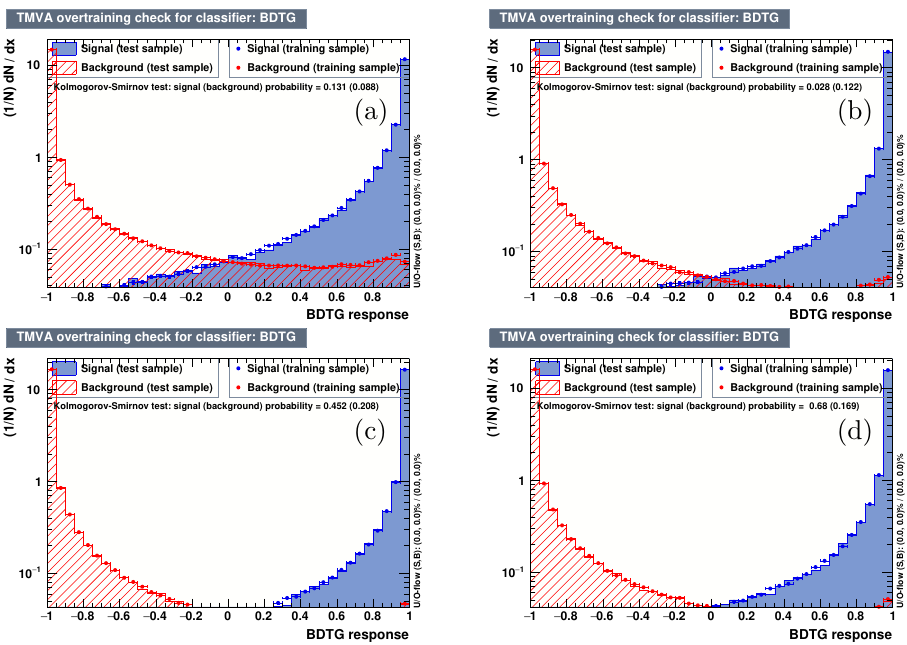
√ s = 350 GeV with π 0 mass v